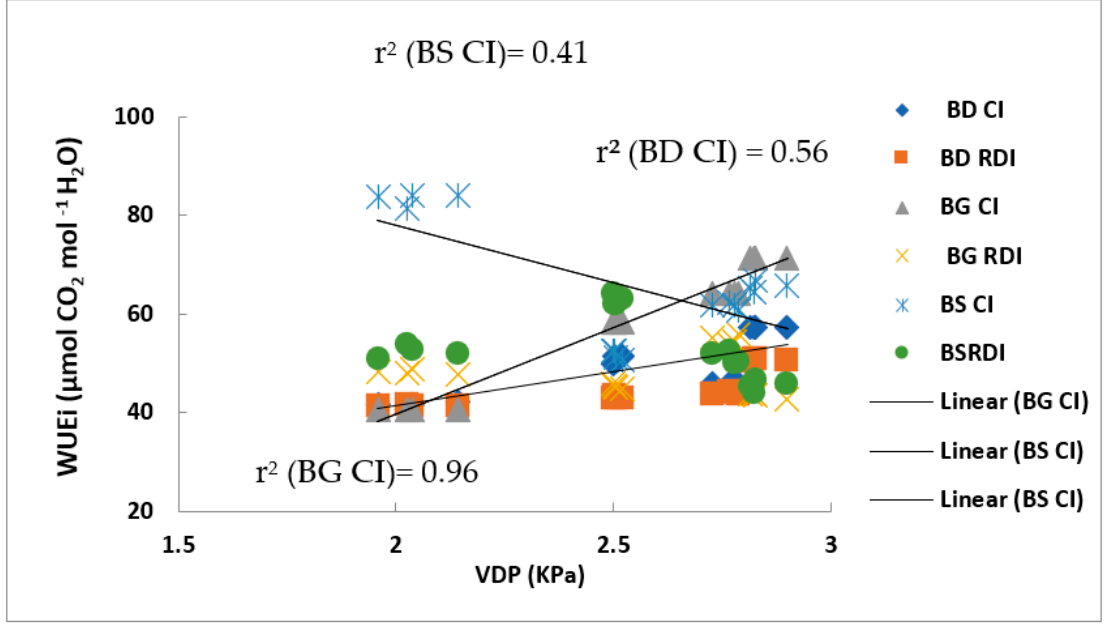
Figure 6. Intrinsic water use efficiency (WUEi = AN/gs) ( μ mol CO 2 mol − 1 H 2 O) and water vapour pressure deficit (KPa) in three Black Diamond, Black Gold, and Black Star cultivars in responses to both water treatments (CI and RDI). Each point is the average of three replications and vertical bars indicate ± SEM. r 2 (CI), r 2 for control irrigation; r 2 (RDI), r 2 for deficit irrigation.